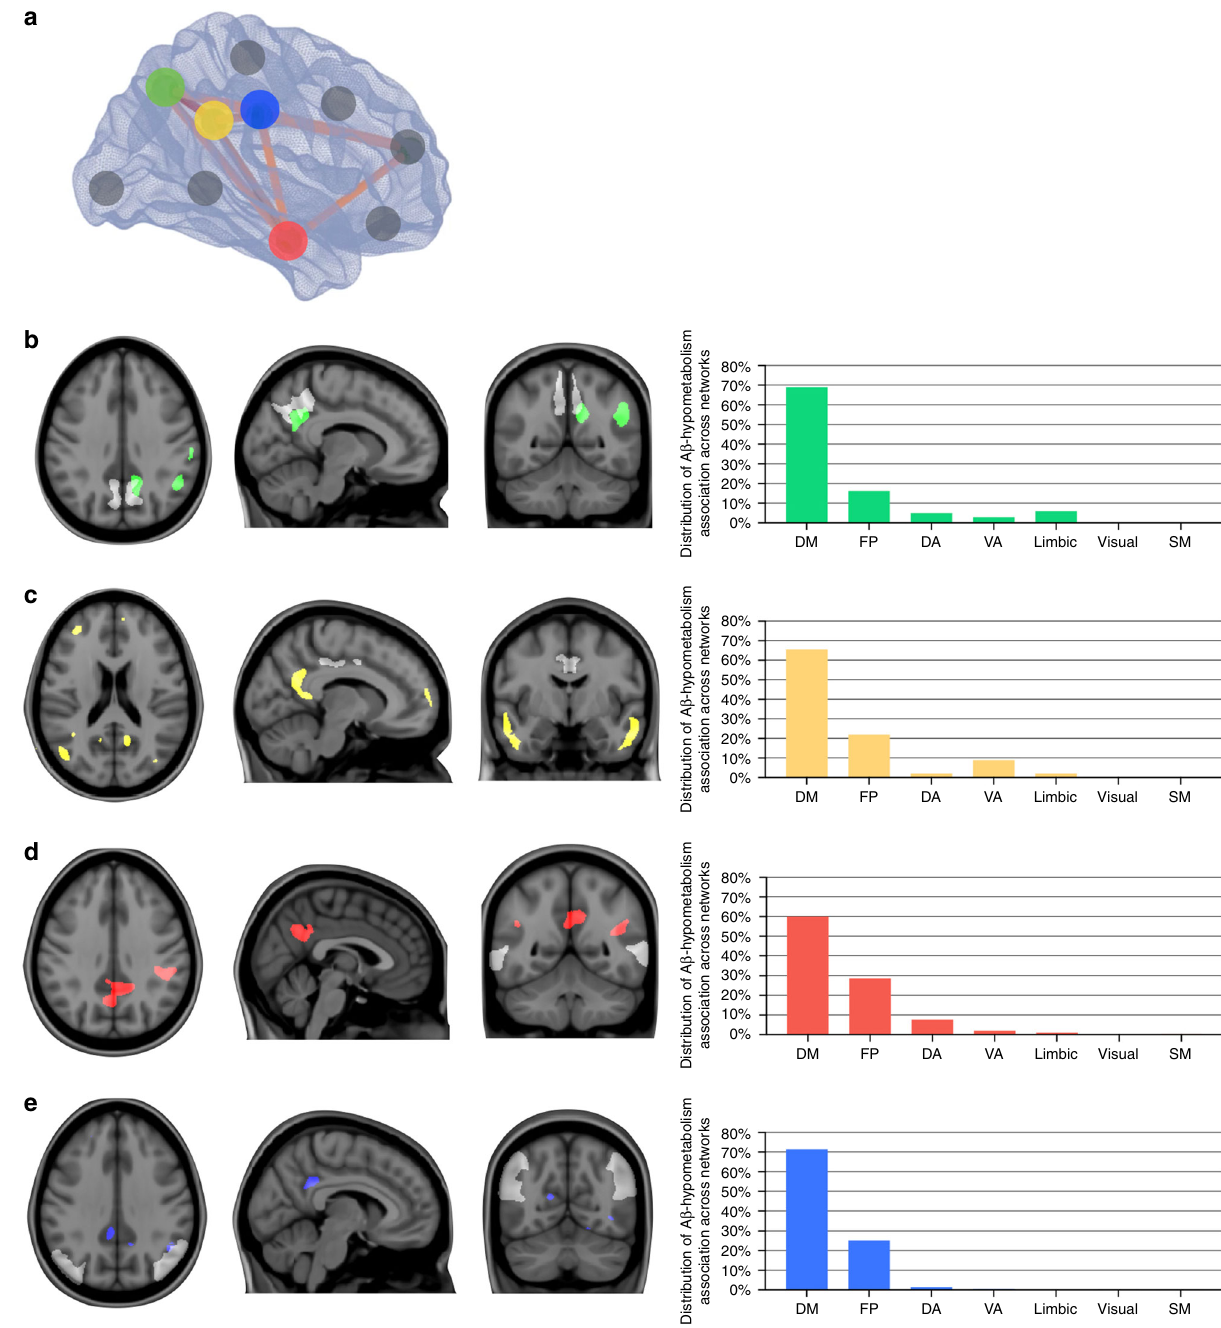
Fig. 3 Amyloid- β (A β ) in DMN is predominantly associated with distant within-network hypometabolism in CN A β positive. a In the 3D brain, the dots represent the regions-of-interest in which A β values were obtained. The regions in which A β values were obtained are also shown in white, superimposed on the structural MRI templates in panels b – e . Statistical parametric maps, overlaid on a structural MRI template, show the brains regions where voxel-wise glucose metabolism was negatively associated with A β load in the ( b ) precuneus (green), ( c ) posterior cingulate (yellow), ( d ) lateral temporal (red), and ( e ) inferior parietal (blue) cortices in CN A β positive ( n = 53). The bar graphs show the distribution of the voxels in the aforementioned statistical parametric maps across seven functional brain networks (DM default mode, FP frontoparietal, DA dorsal attention, VA ventral attention, limbic visual, SM somatomotor). Thus, the sum of the seven bars in each graph is 100%. A β in the medial prefrontal, anterior cingulate, orbitofrontal, paracentral, insular, and occipital pole cortices (gray dots) did not signi fi cantly associate with hypometabolism. Parametric images were FWER corrected at P < 0.05 and adjusted for age, gender, education, APOE ε 4 status, p-tau, and gray matter